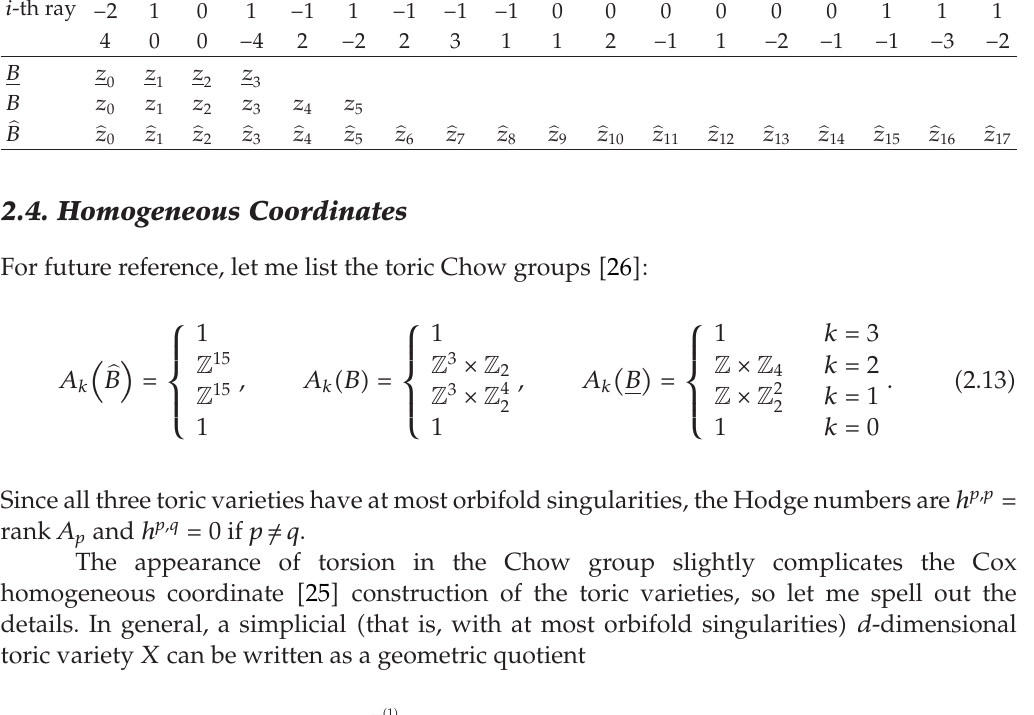
(cid:2) red and blue dots (cid:3) . B